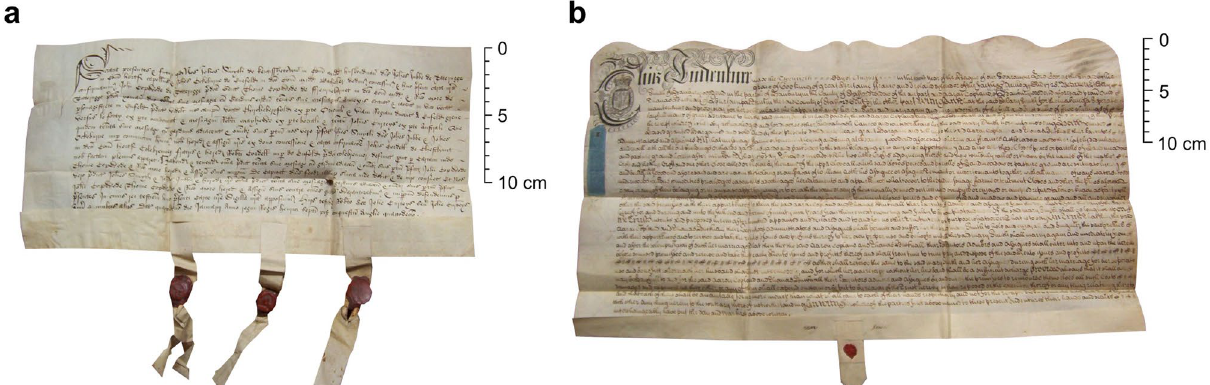
Figure 1. Legal deeds. ( a ) Title deed concerning the ownership of land in Enfield, Middlesex, signed and sealed 15th January 1499 (sample DL035); ( b ) title deed concerning property in Hanbury Woodend, Staffordshire, signed and sealed 11th August 1728 (sample DL110).